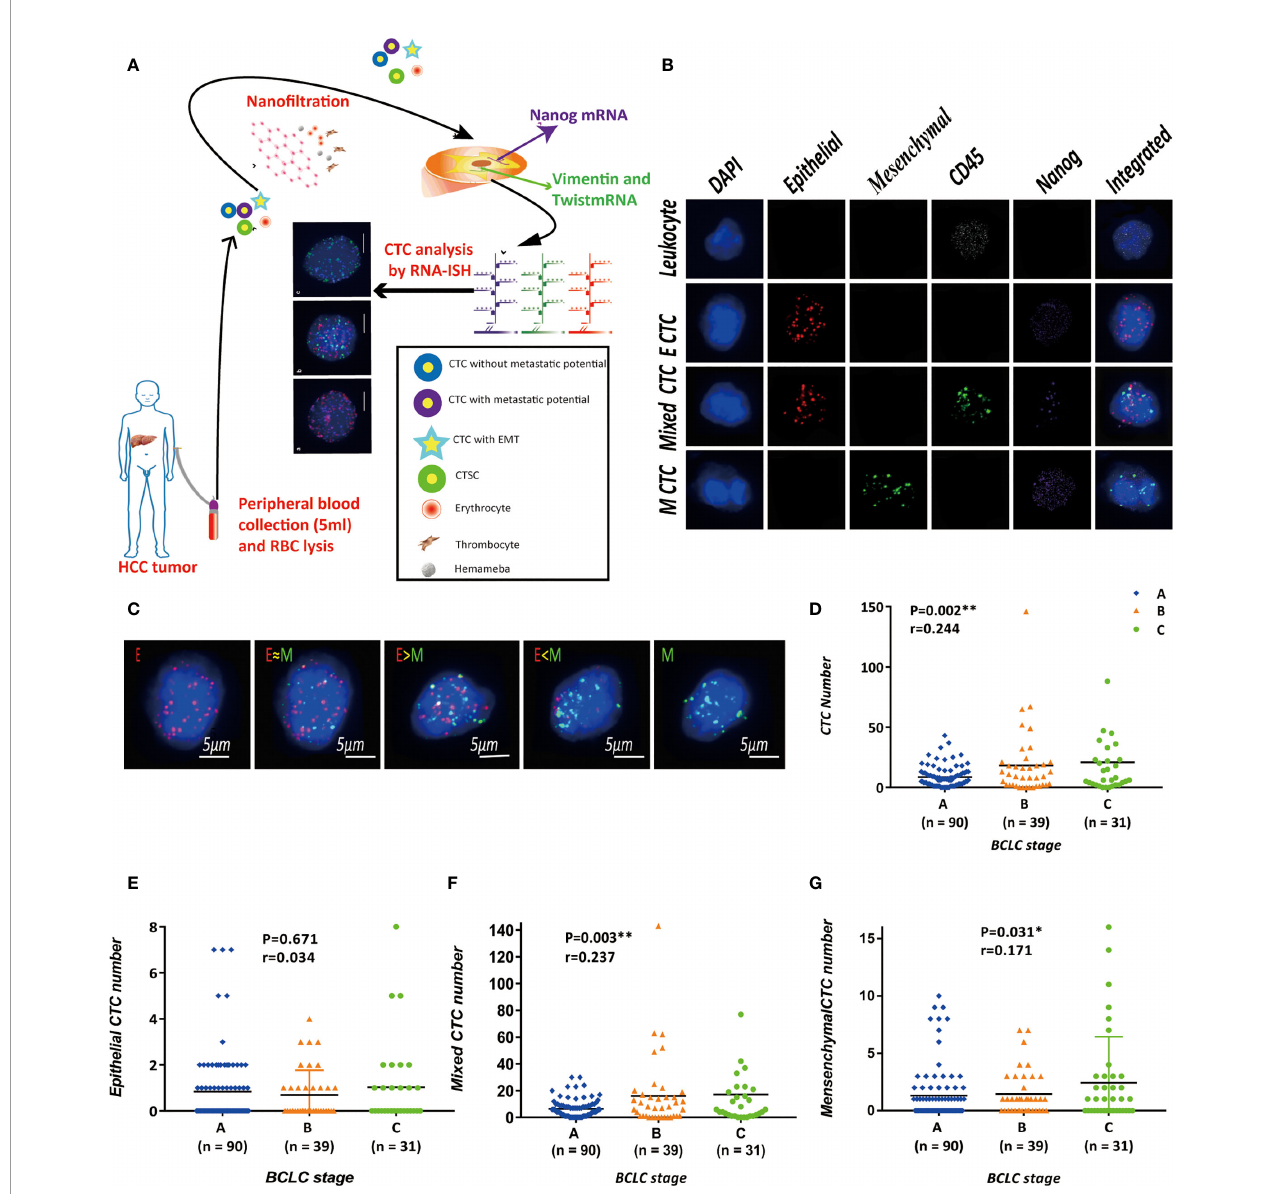
FIGURE 1 | Use RNA-ISH technology to enrich and analyze CTCs in blood samples of HCC patients (A) The expression of epithelial marker mRNA (EpCAM and E- cadherin) and (B) mesenchymal marker mRNA (Twist and vimentin) and CSC marker mRNA (nanog) were validated by qPCR, p<0.05; (C) The protein expression levels of epithelial markers (EpCAM and E-cadherin), p<0.001. (D – G) The total number of CTCs, epithelial CTCs, mixed CTCs, and mesenchymal CTCs correlated with BCLC staging,